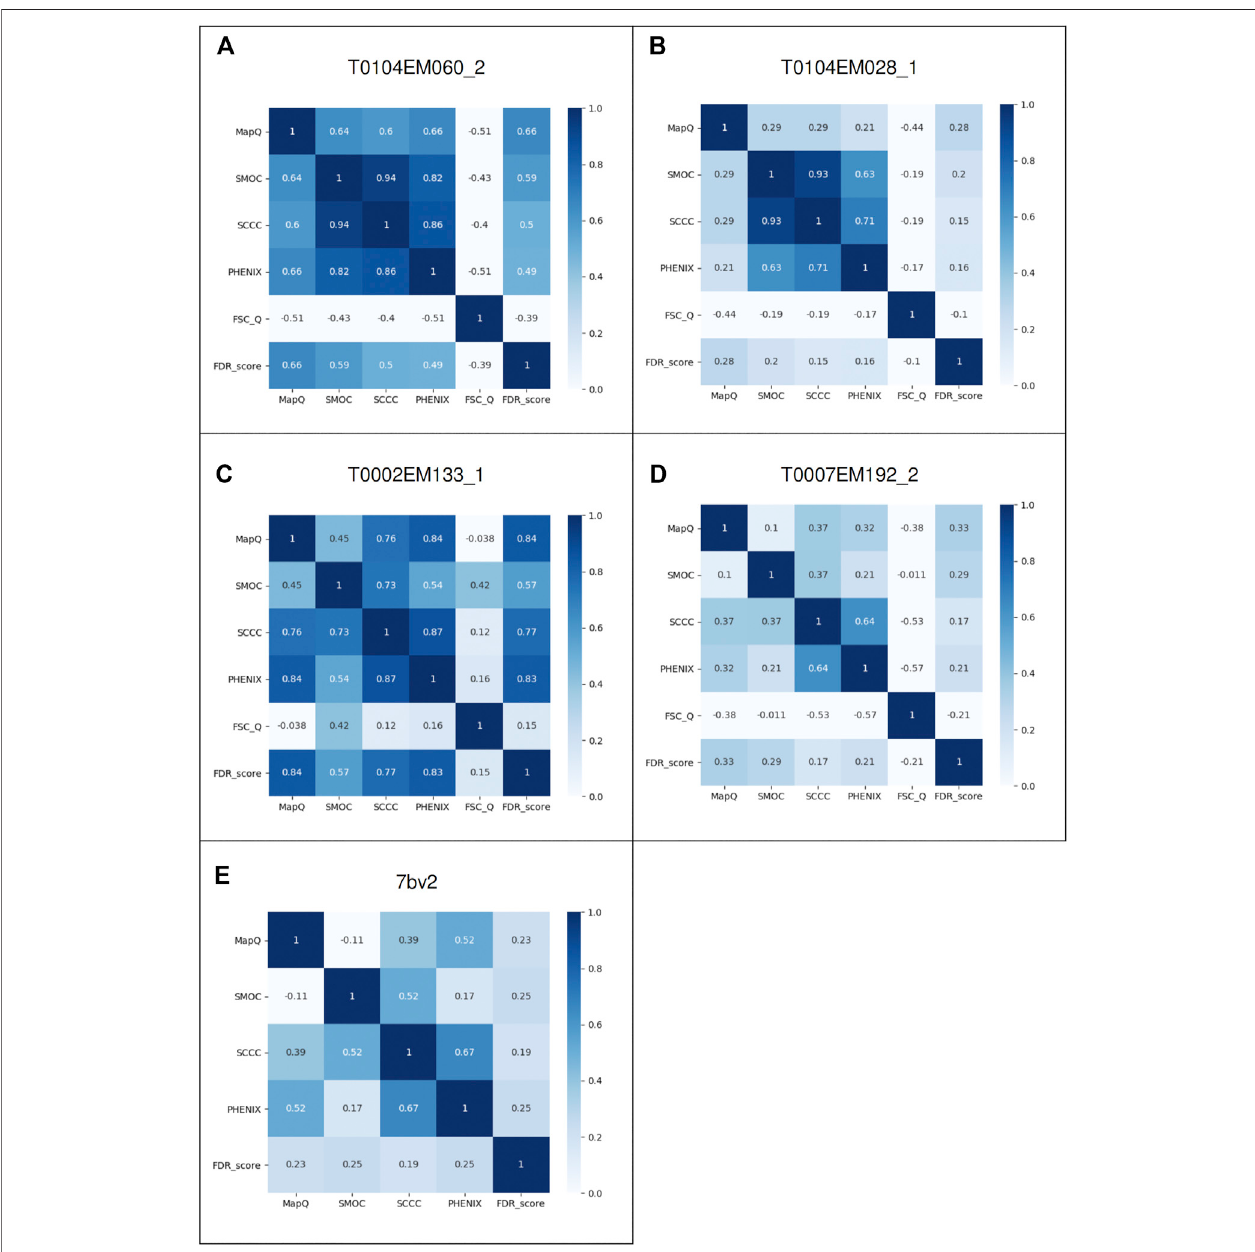
FIGURE 6 | Pairwise correlations of different metrics: MapQ, SMOC, SCCC, PHENIX, FSC-Q, and FDR backbone score for the atomic models: (A) Chain A of alcoholdehydrogenase T0104EM060_2, (B) chainA ofT0104EM028_1, (C) chain L ofT20sproteasome T0002EM133_1, (D) chain Cof γ -secretase T0007EM192_2, and (E) chain B of the RNA polymerase complex model